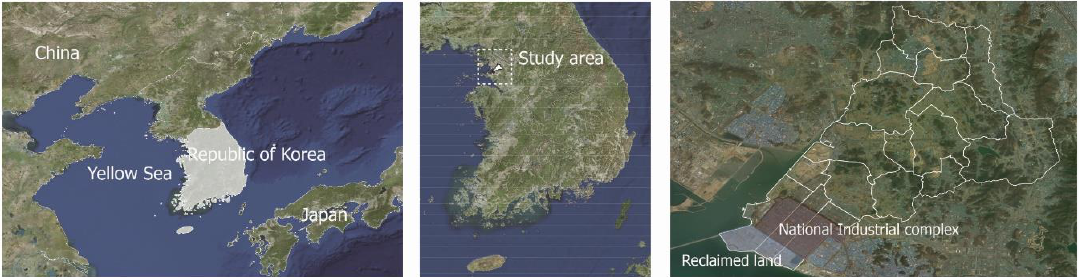
Figure 1. The location of the study area in the Republic of Korea. F igure 1. The location of the study area in the Republic of Korea.